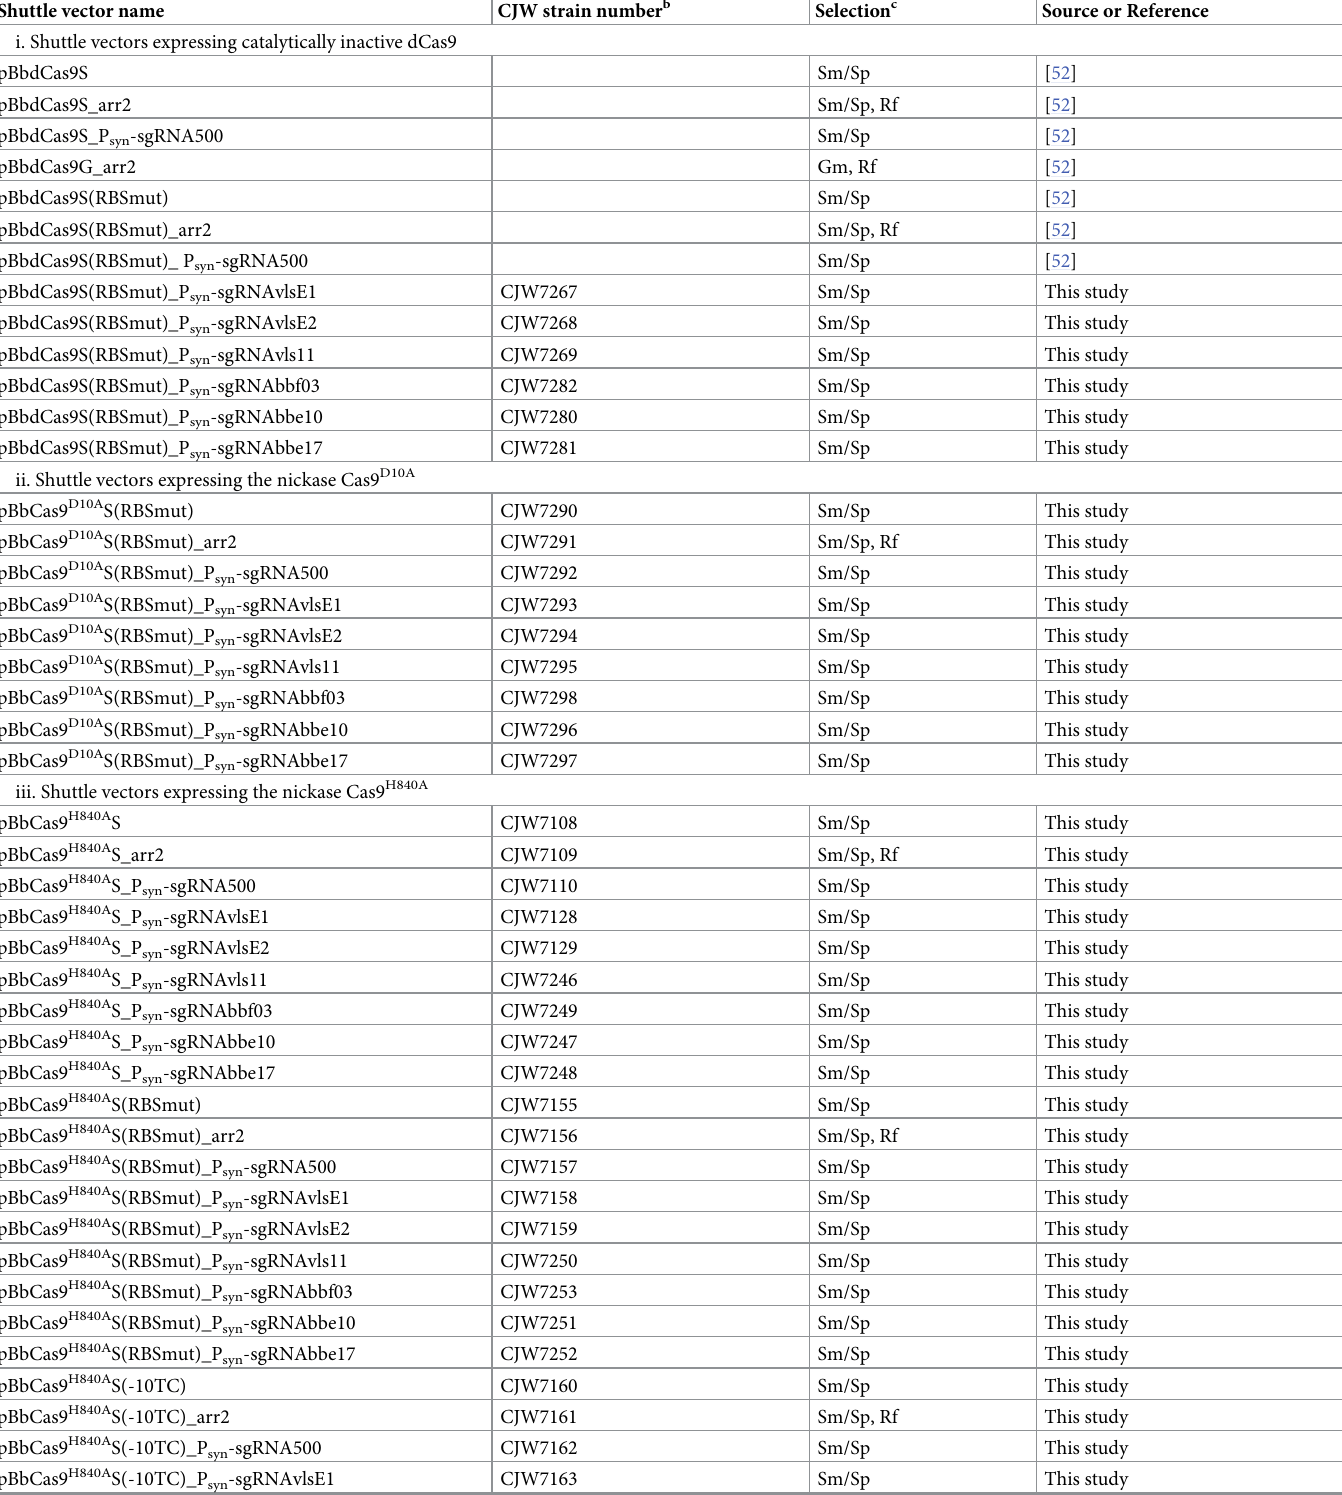
Table 1. E. coli/B . burgdorferi shuttle vectors a used in this